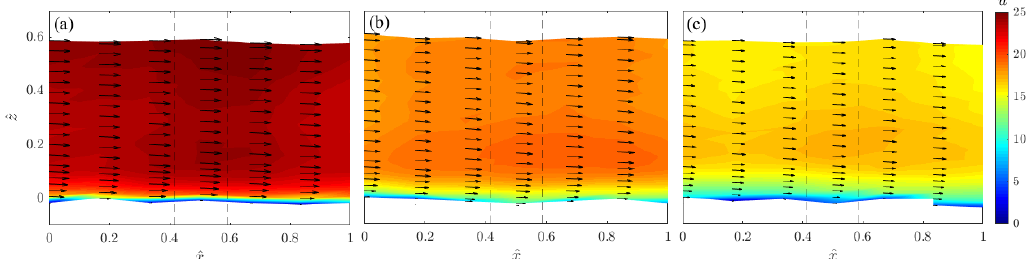
Figure 2. Contours of dimensionless time-averaged velocity and 2D velocity vectors measured on the vertical central plane for ( a ) Run 1, ( b ) Run 2, and ( c ) Run 3. The black broken lines indicate the edge of the vegetation stem.